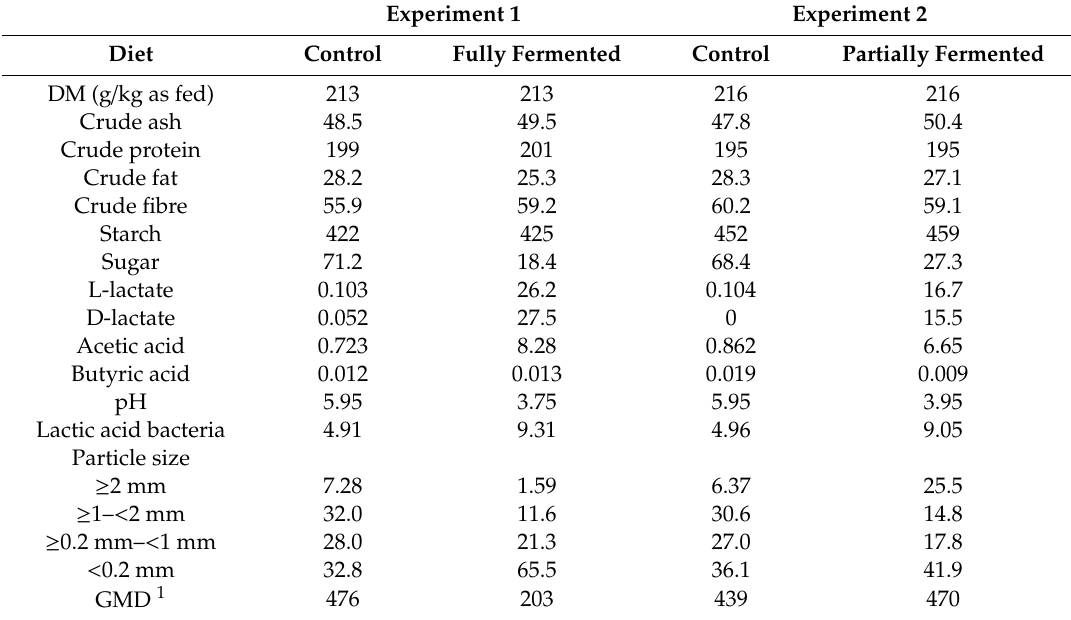
Table 1. Chemical composition (g / kg DM) of the diets, lactic acid bacteria counts (log10 cfu / g diet) as well as proportion of particle sizes (% of DM) measured by wet sieve